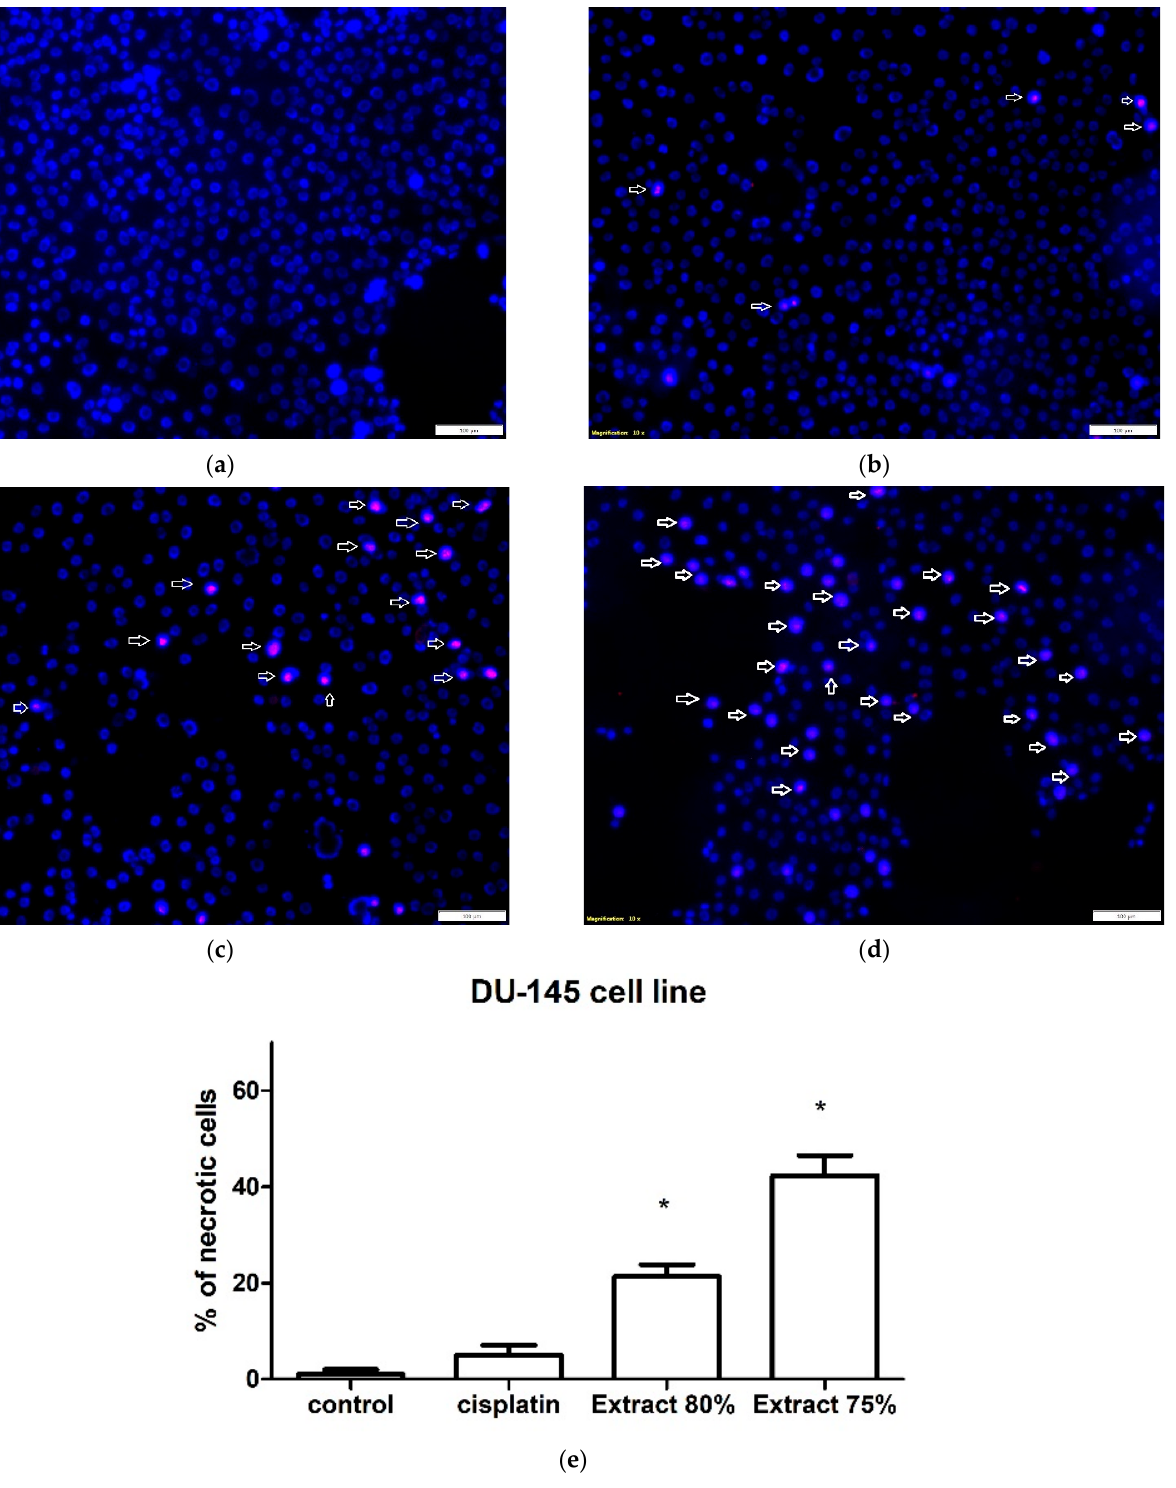
Figure 5. Effects of the tested extracts on the induction of DU-145 cell death: ( a ) control; ( b ) cisplatin at 25 µg/mL; ( c ) 80% extract at 25 µg/mL; ( d ) 75% extract at 25 µg/mL. Propidium iodide (red) and Hoechst 33342 (blue) staining. Magnification, 10×. Necrotic cell nuclei were stained pink. The number of necrotic cells per 100 PC-3 cells was assessed in three visual fields. Data are presented as means ± SDs. Significant values (*) compared with control with p < 0.05 (one-way ANOVA with Tukey’s post hoc test) ( e ).